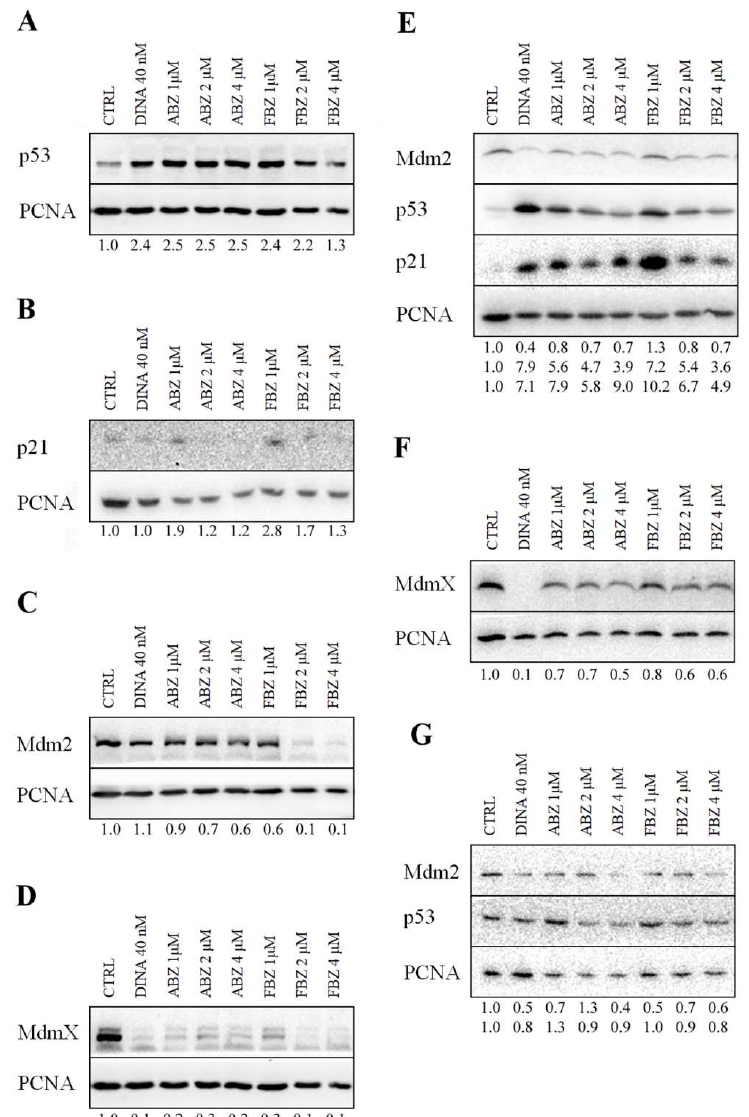
Figure 3. E ff ect of benzimidazoles on p53 and related proteins levels. DINA (40 nM) was used as a positive control. Solvent (DMSO)-treated cells were used as a negative control (CTRL). ( A – D )